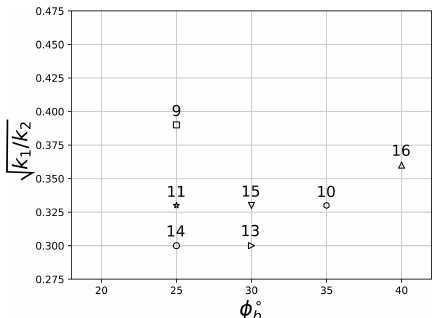
√ k 1 /k 2 and φ b ) for